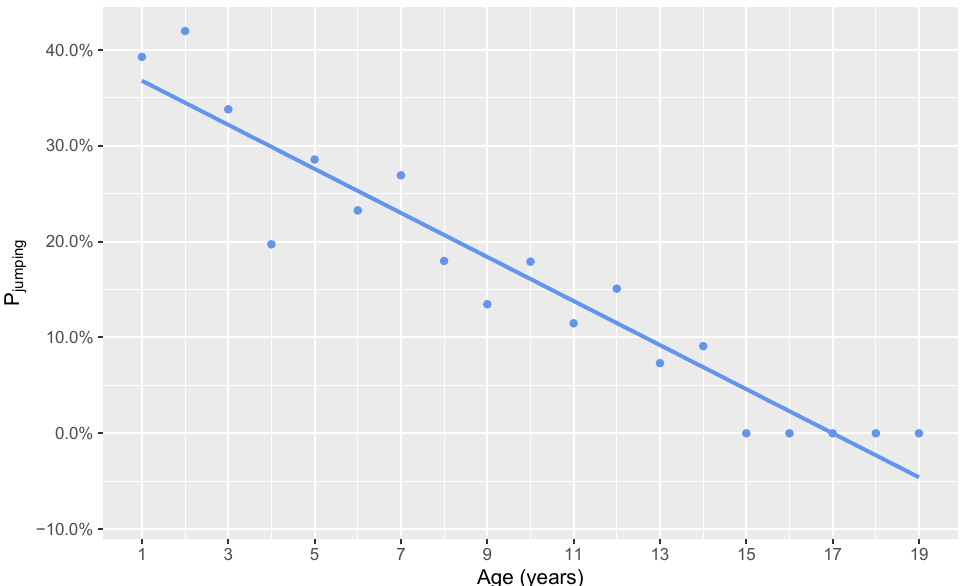
Figure 2. A smooth geometric means plot for the probability of exhibiting problematic jumping versus the current age of the dog in years.